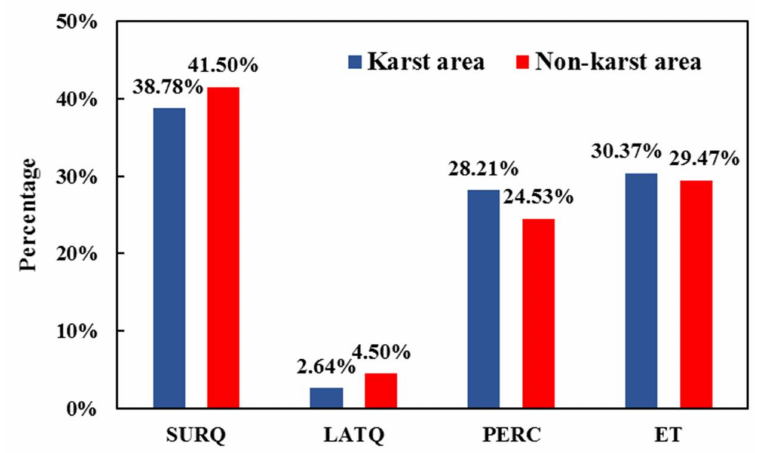
Figure 6. Percentage each water balance term contributed to total precipitation in karst and non-karst areas.